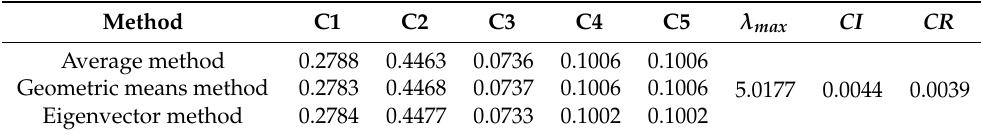
Table 6. The weight coefficients of the judgment matrix O − C .